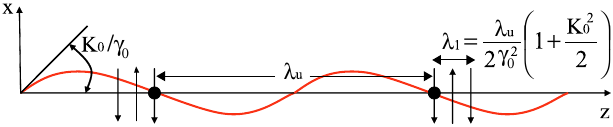
FIG. 2. (Color) After an electron (black dot) travels one undu- of the sinusoidal trajectory (in red), a plane wave lator period (cid:2) u (represented by alternating vertical arrows) overtakes the elec- . Thus, the undulator radia- FIG. 3. (Color) Growth of the radiation power and the electron tron by one resonant wavelength (cid:2) 1 tion carrying this resonant wavelength can exchange energy with beam microbunching as a function of the undulator distance for a the electron over many undulator periods. high-gain